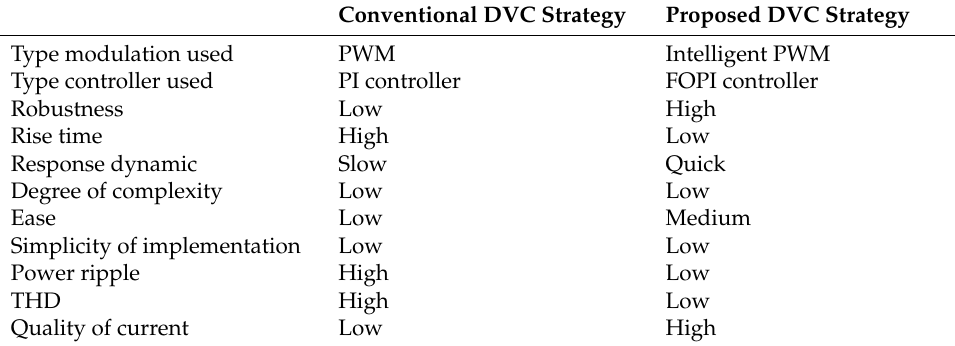
Table 2. A comparative study between the traditional and proposed DVC